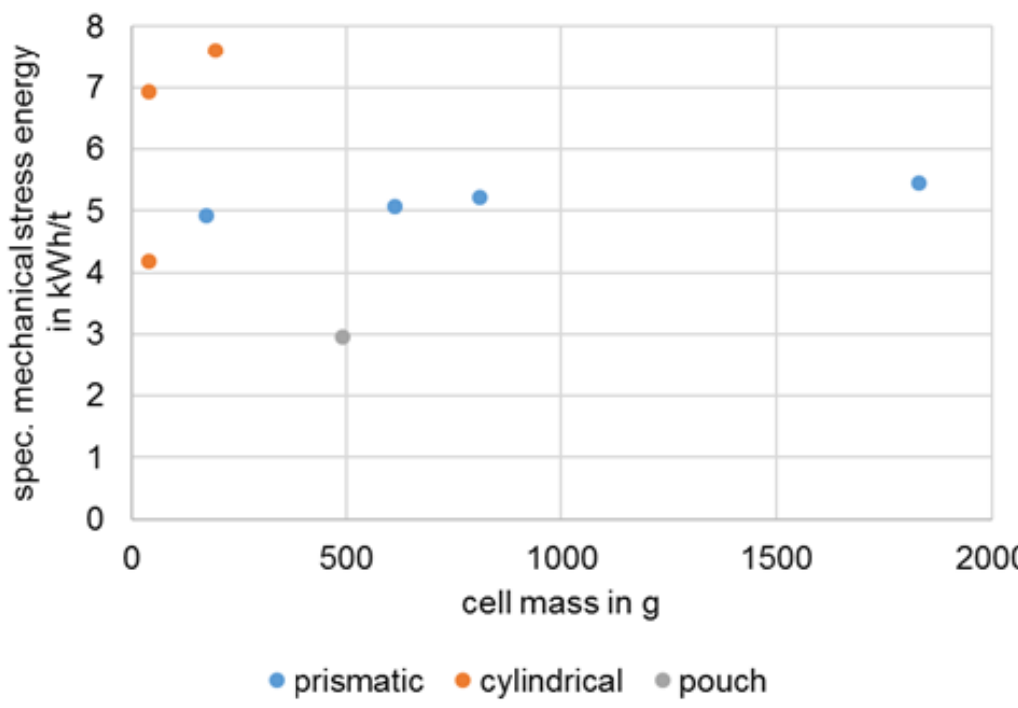
Figure 12. Stress energy for comminution of different types and sizes of battery cells by means of rotor shears and granulator.